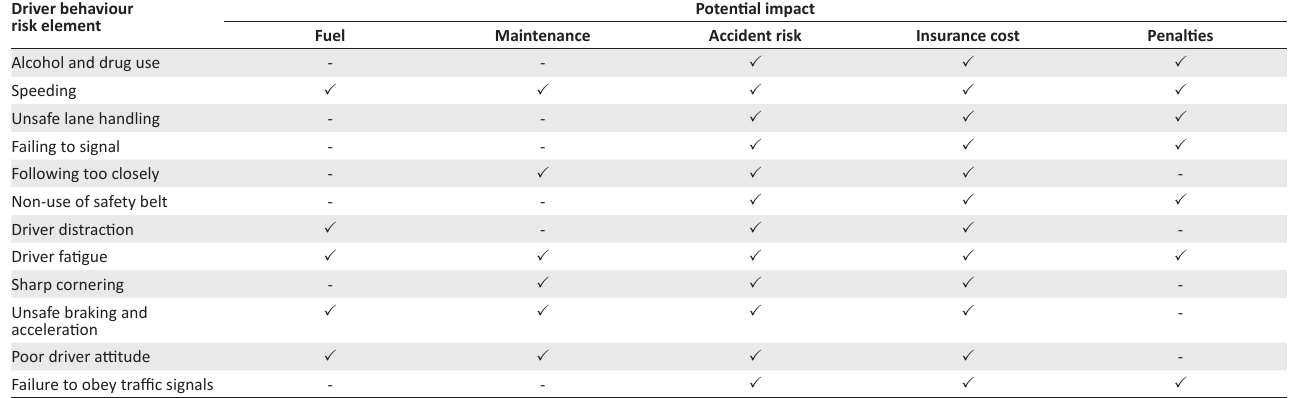
TABLE 1 : Business impact of risky driver behaviour. Driver behaviour risk